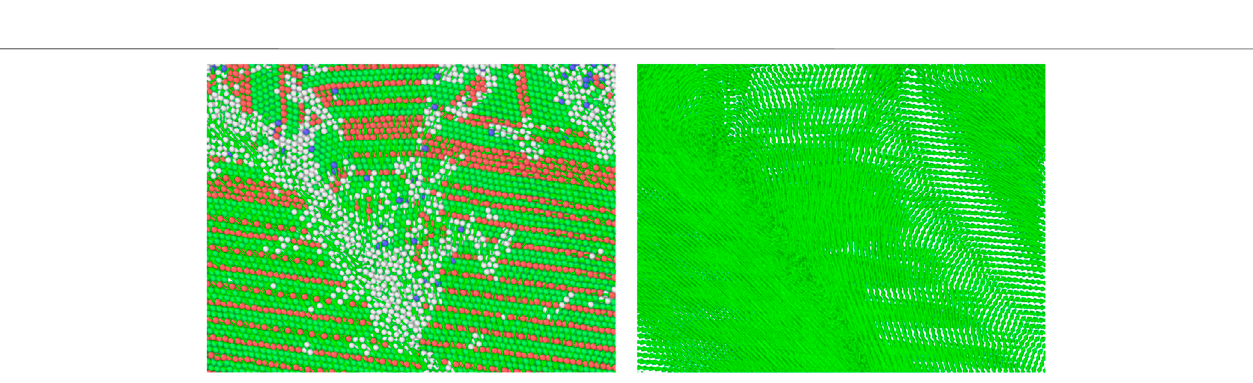
FIGURE 14 | The cross-sectional view of the displacement vectors of atoms under tension loading at strain of 10 and 15%.